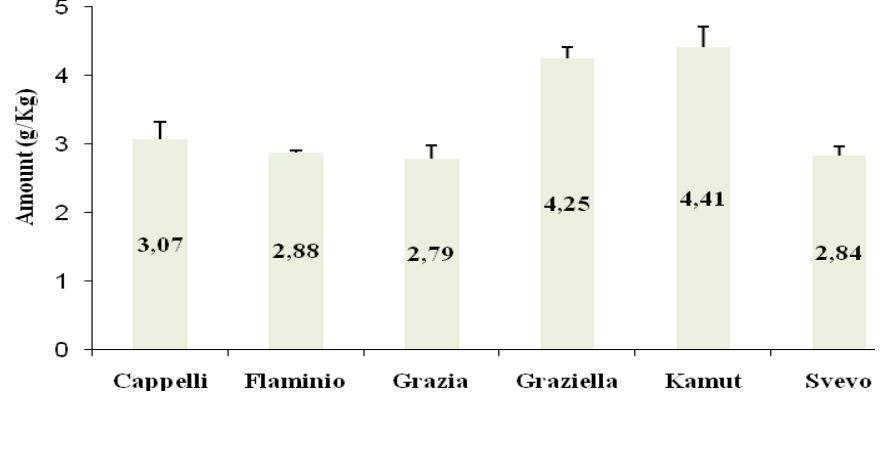
Figure 3. A-gliadin peptide p56-75 (LQLQPFPQPQLPYPQPQLPY) quantitative determination by CDC-5 mAb. All values are reported as mean ± SD from three independent experiments.